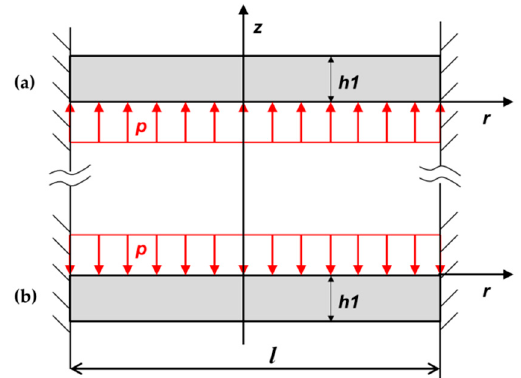
Figure 2. Shear-force diagram of a cavity growth inside the plate. ( a ) distributed load on the top edge and ( b ) on the bottom edge.